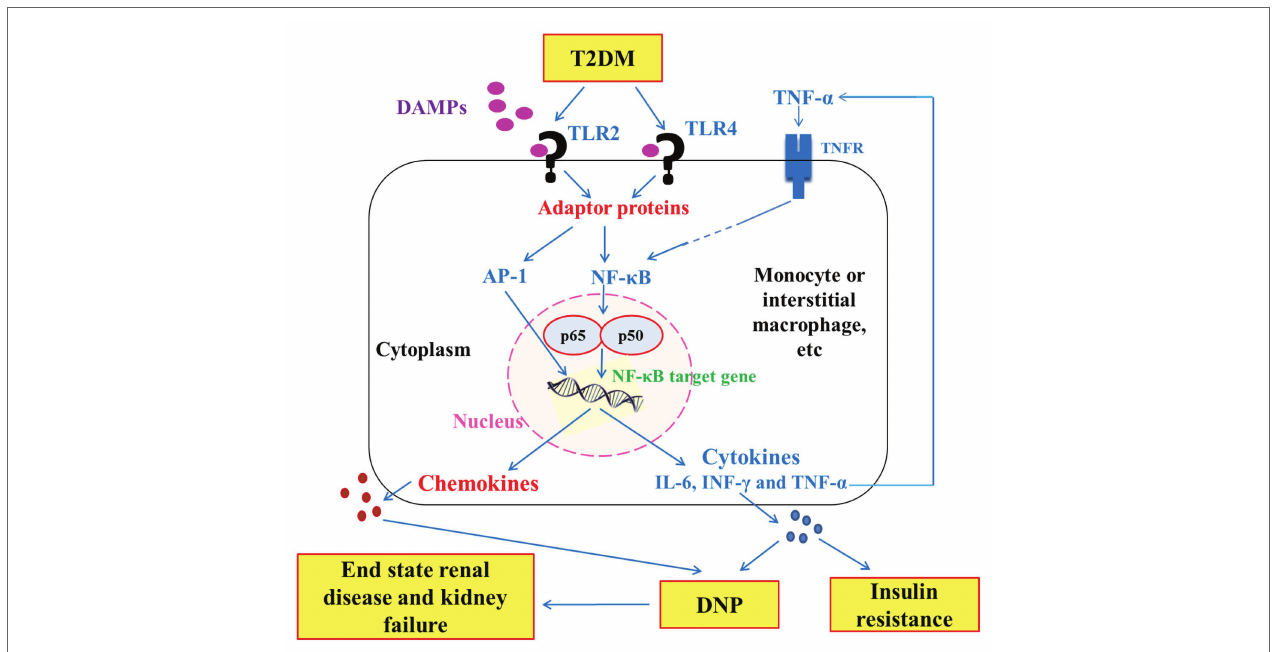
FIGURE 6 | Schematic diagram showing the downward signaling pathways of TLR2 and TLR4 to the release inflammatory cytokines that have an important role in insulin resistance and pathogenesis of diabetic nephropathy (DNP) in type 2 diabetes mellitus (T2DM). DAMPs: Damage-associated molecular patterns; TNFR: tumor necrosis factor receptor; NF- κ B: nuclear factor-kappaB; and AP-1: Activator protein